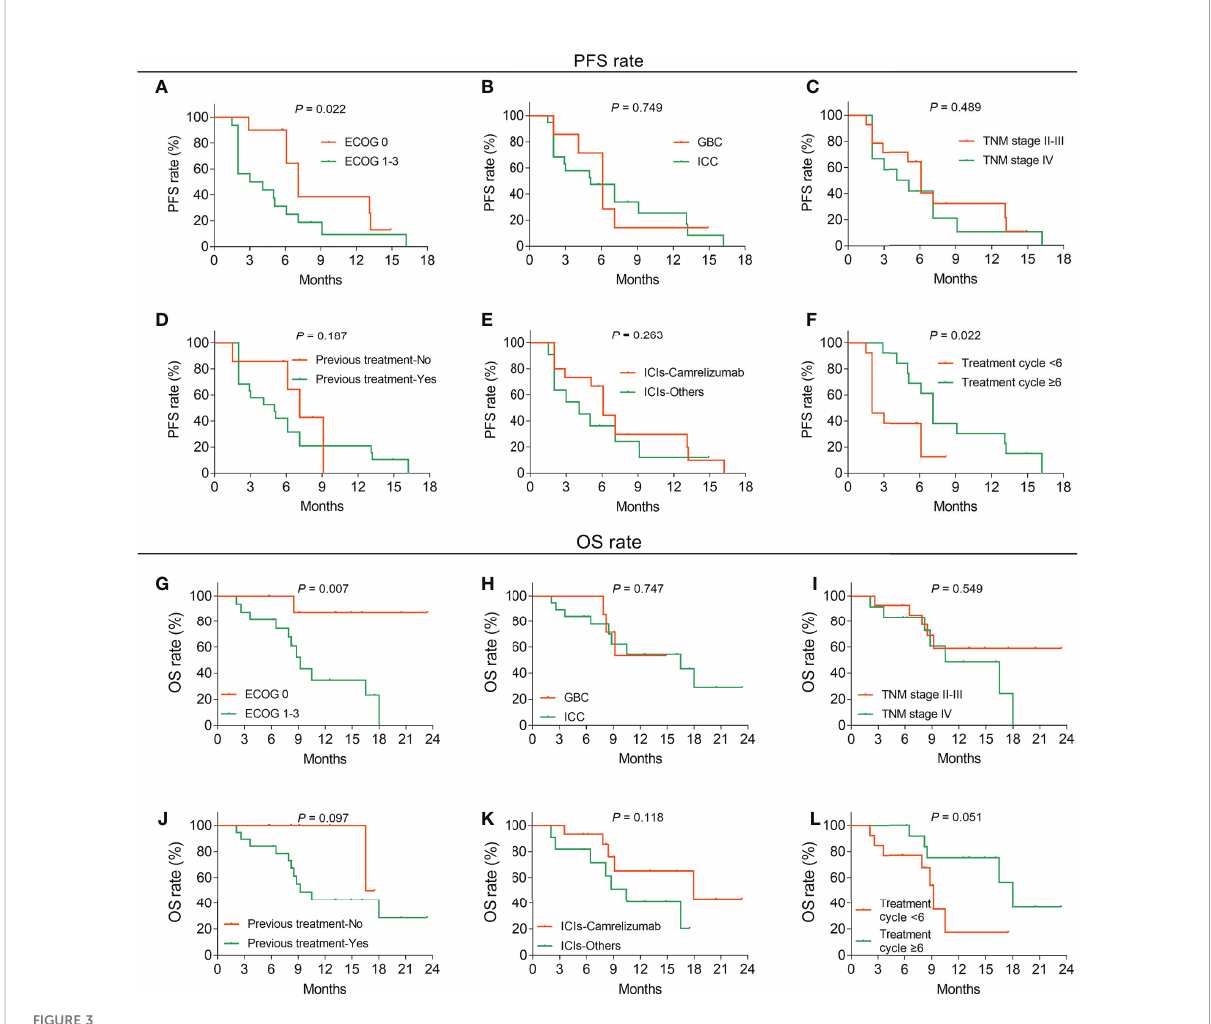
FIGURE 3 Factors related to PFS and OS in BTC patients. Correlation of ECOG score (A) , histological type (B) , TNM stage (C) , previous treatment (D) , ICI types (E) , and treatment cycles (F) with PFS in BTC patients. Association of ECOG score (G) , histological type (H) , TNM stage (I) , previous treatment (J) , ICI types (K) , and treatment cycles (L) with PFS in BTC